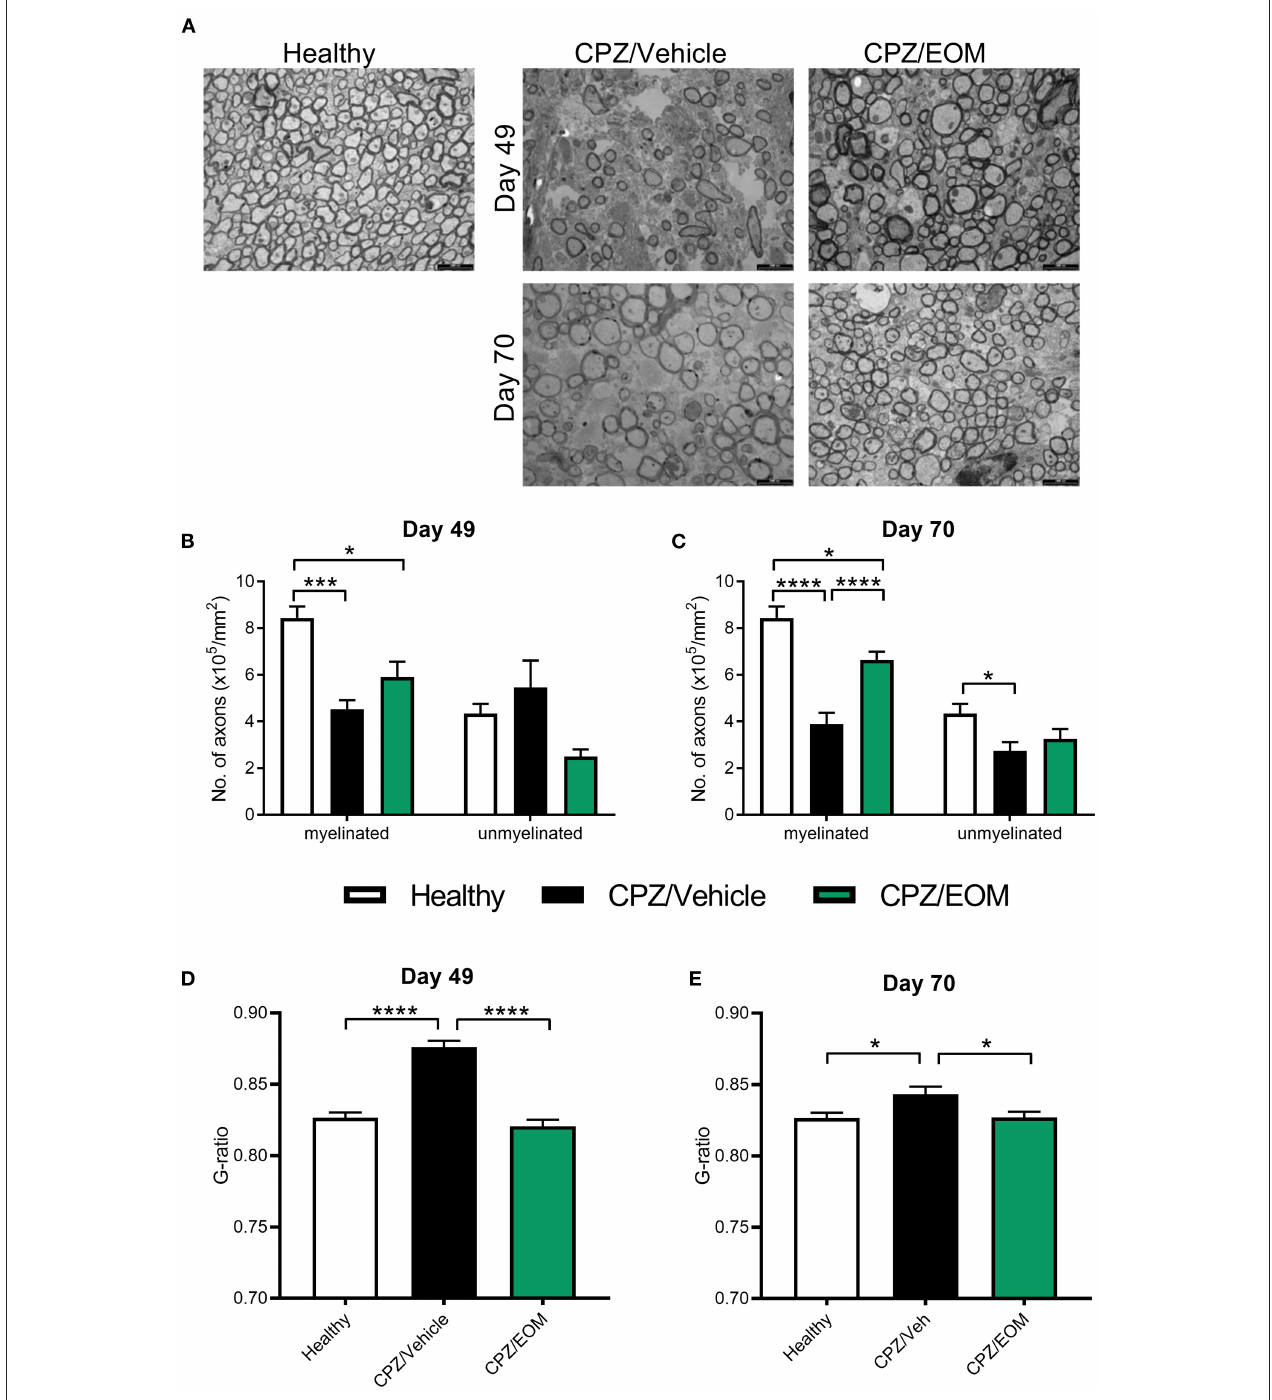
FIGURE 6 | EOM SalB treatment increased remyelination within the corpus callosum of mice administered 0.3% cuprizone. (A) Representative transmission electron microscopy images showing myelinated and unmyelinated axons in the corpus callosum of healthy and mice administered cuprizone (CPZ) and treated with either vehicle (Veh) or EOM SalB (0.3 mg/kg). The number of myelinated and unmyelinated axons were counted at (B) day 49 and (C) day 70. EOM SalB (0.3 mg/kg) treatment led to an increase in the number of myelinated axons at day 70. Two-way ANOVA with Tukey’s multiple comparisons test. The g-ratio of each axon was calculated by dividing the inner axonal diameter by the outer diameter at (D) day 49 and (E) day 70. EOM SalB treatment decreased the g-ratio to healthy levels at days 49 and 70. One-way ANOVA with Tukey’s multiple comparisons test. Five images per animal, three animals per treatment group. Scale bar is 2,000nm. Data presented as mean ± SEM. * p < 0.05, ** p < 0.01, *** p < 0.001, **** p <